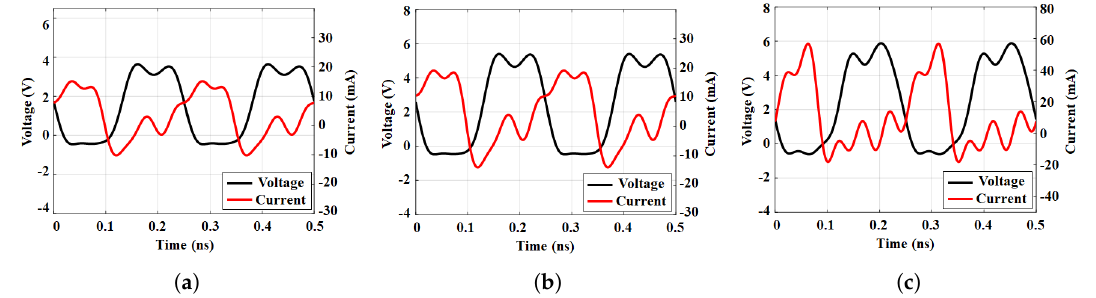
Figure 6. Diode voltage and current waveforms according to the number of stages; ( a ) one—stage HTVM; ( b ) two—stage HTVM; ( c ) three—stage HTVM.